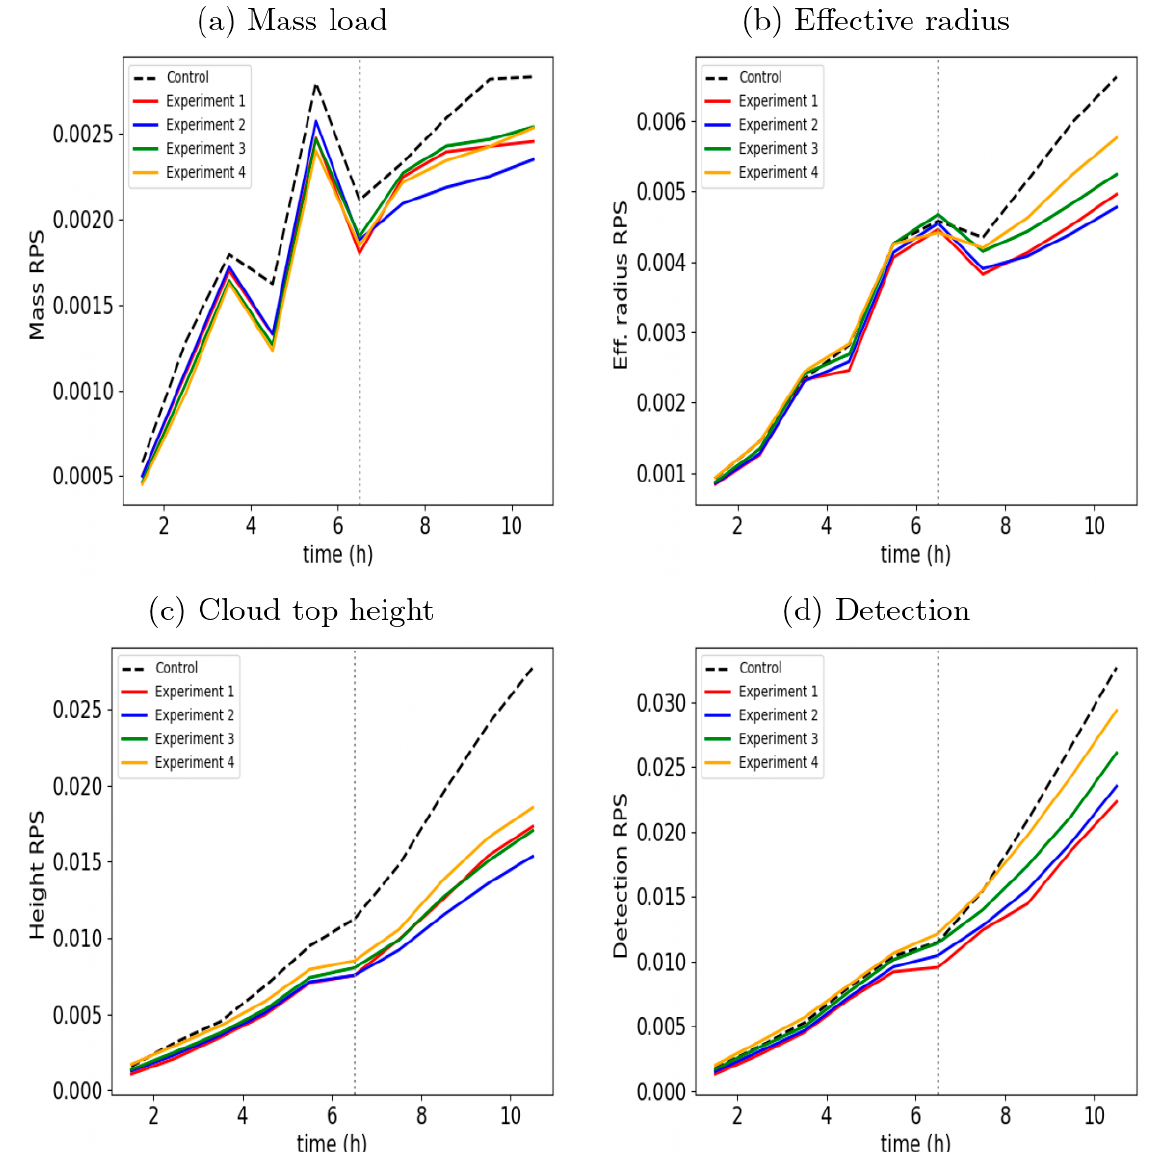
Figure 9. Ranked probability scores (RPS) for different fields as a function of time for the control run and experiments in this study. The experiments utilize different values of 𝛽 (see Table 2). Lower RPS values indicate better probabilistic skill. The dotted vertical line demarcates the analysis and forecast periods.